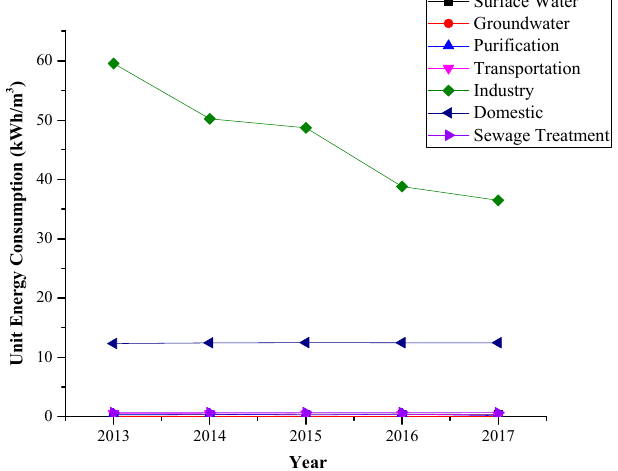
Figure 7. Year-by-year changes in energy consumption of the water utilization stage in Ordos, China.